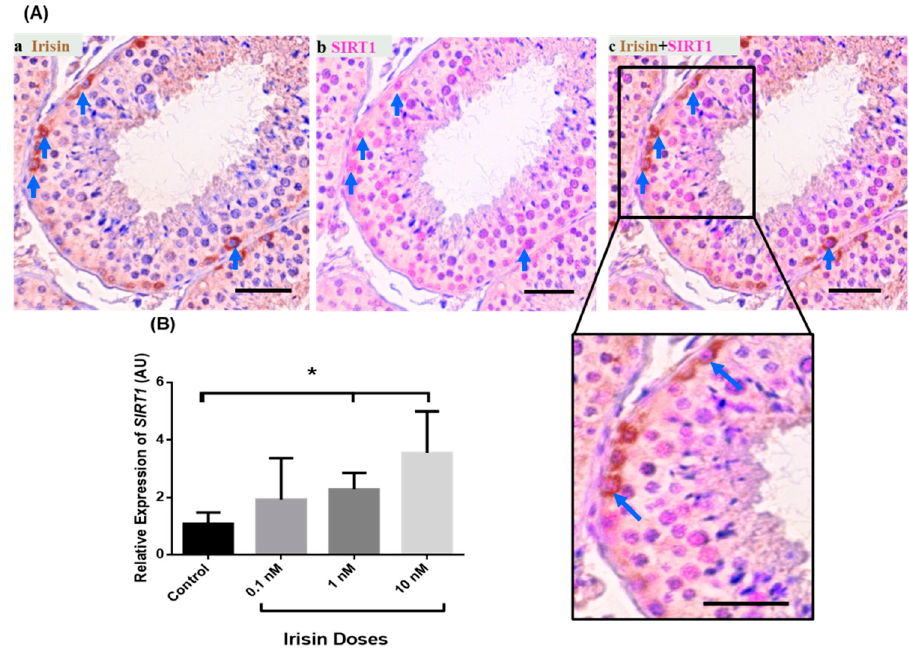
Figure 5. Double staining of SIRT1 and irisin on marmoset testis sections. ( A ) Irisin-positive